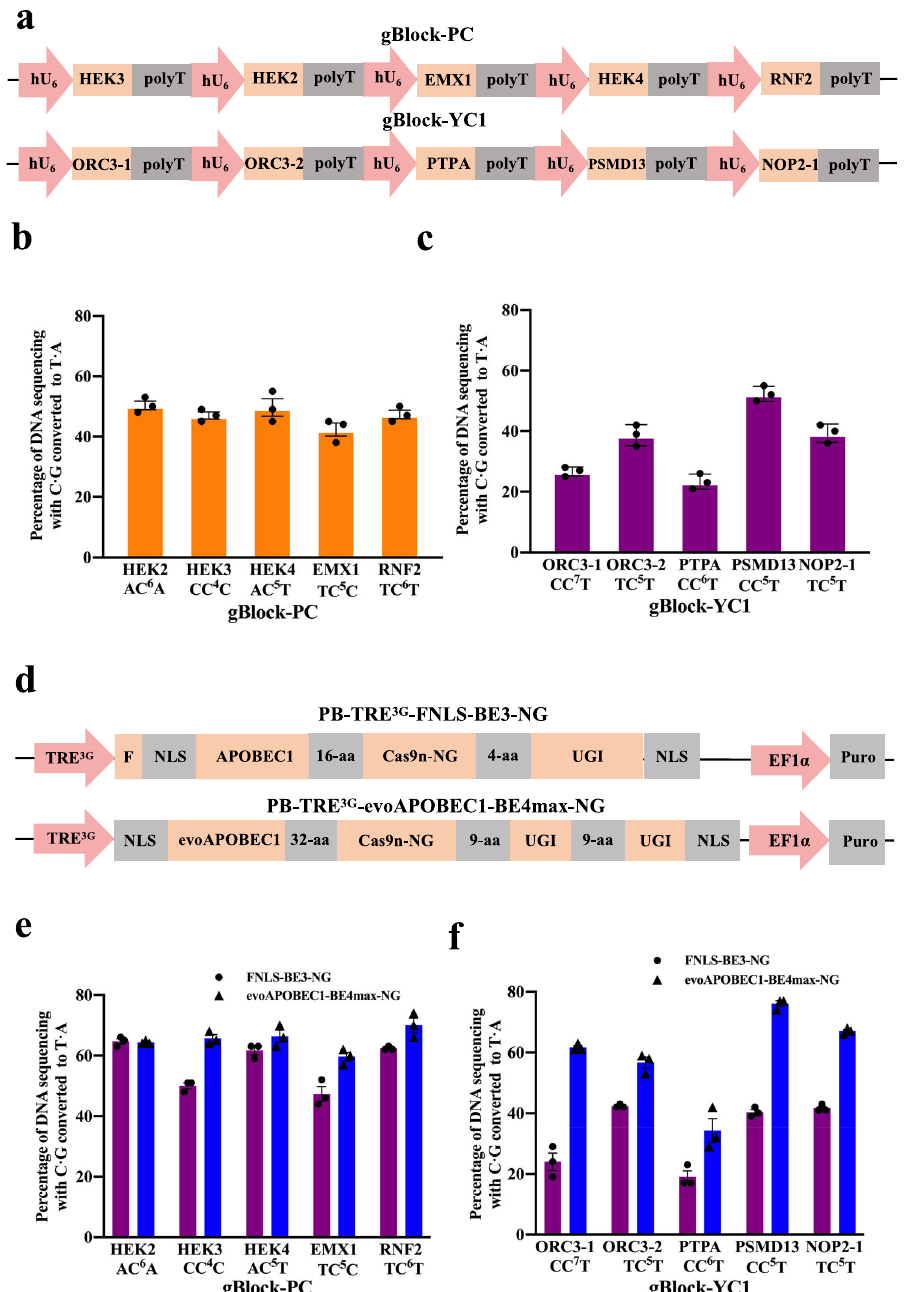
Fig. 2 Multiplexed base editing in HEK293T cells by gRNAs array. a Schematic diagram of gBlock-PC and gBlock-YC1. gBlock-PC carries published fi ve sgRNAs targeting at fi ve endogenous loci (HEK2, HEK3, HEK4, EMX1, RNF2) and gBlock-YC1 carries 5 sgRNAs targeting TAG of fi ve genes loci (ORC3-1, ORC3-2, PTPA, PMSD13, NOP2-1). Co-transfected with gblock-PC ( b ) and gBlock-YC1 ( c ) with evoAPOBEC-BE4max-NG into HEK293T cells separately. Frequency (%) of C-to-T conversion was obtained by Sanger sequencing and editR analysis. d Schematic diagram of dox-inducible cytidine deaminase piggyBac construct. F Flag tag, NLS Nuclear localization signal, Cas9n-NG, Cas9D10A with recognizing NG PAM. APOBAEC1, rat APOBEC1; evoAPOBAEC1, evolved rat APOBEC1. Frequency (%) of C-to-T conversion in two stable HEK293T cell lines (FNLS-BE3-NG ( e ) and evoAPOBEC1-BE4max-NG ( f )) transduced with gBlock-PC and gBlock-YC1 separately. In b , c , e , and f , dots and triangle represent individual biological replicates ( n = 3 independent experiments) and bars represent mean with piggybacFNLS-BE3-NG 32 and evoAPOBEC1-BE4max-NG respectively (Fig. 2d). We transiently transfected gBlock-PC and gBlock-YC1 separately into each of the two inducible CBE cell lines and the editing ef fi ciency of sgRNAs from the gBlock-PC is ~60 – 70% across genes in the evoAPOBEC1-BE4max-NG cell line, which is slightly higher than ~45 – 65% in the FNLS-BE3-NG cell line (Fig. 2e). However, the ef fi ciency of sgRNAs from the gBlock-YC1 is